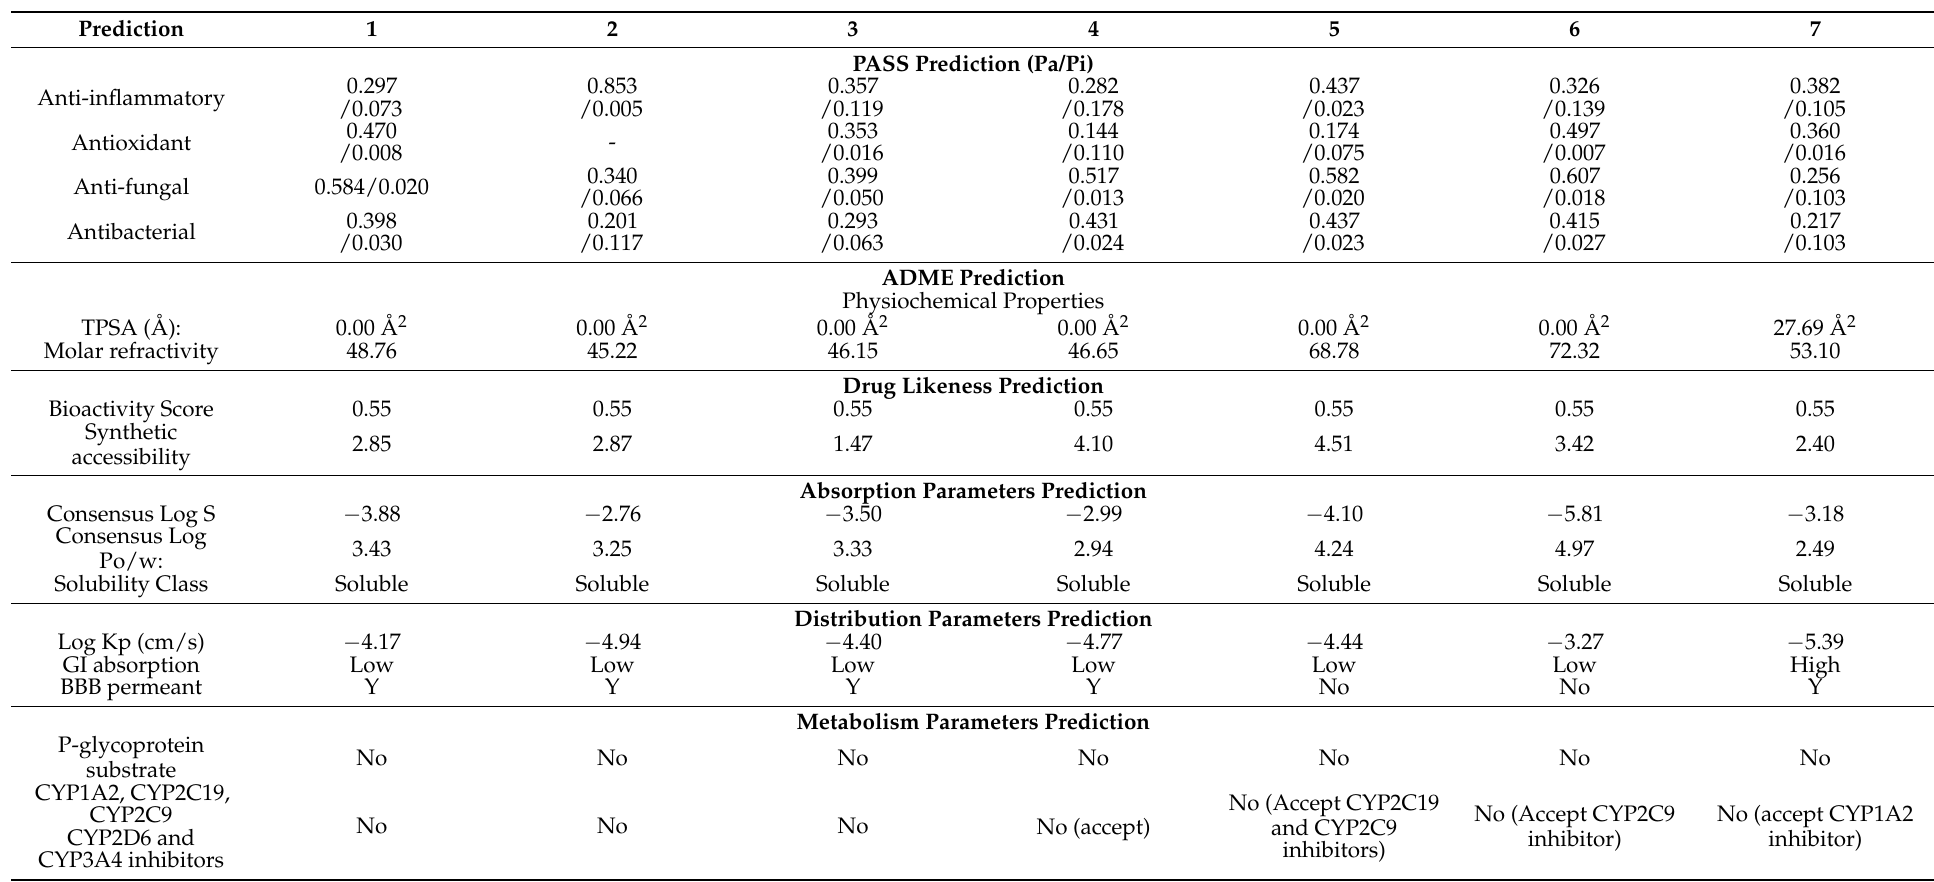
Table 4. In silico PASS and ADME Prediction of PCEO major